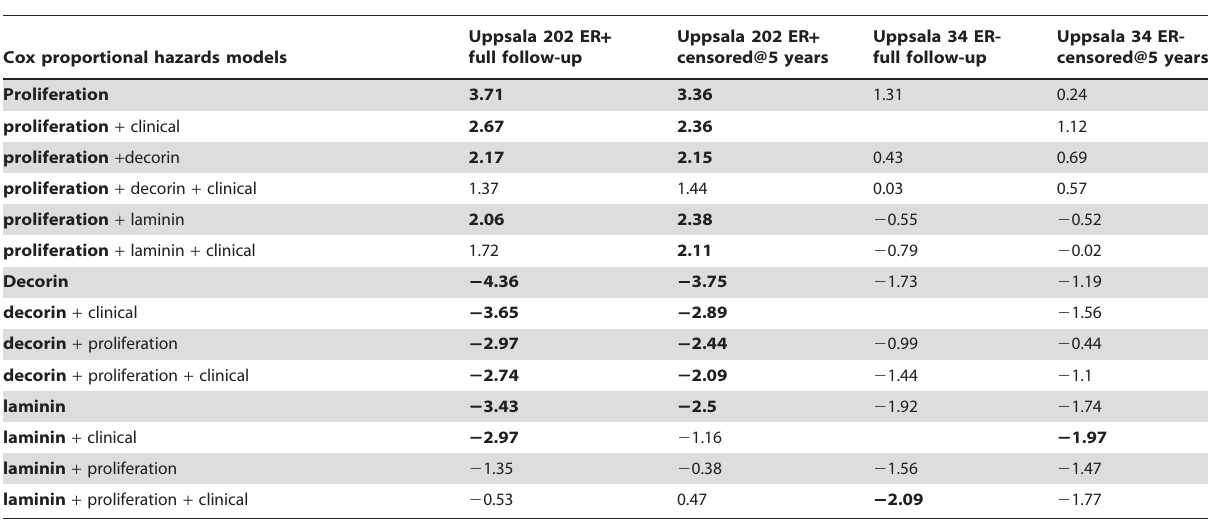
Table 2. Cox proportional hazards models for the UPPSALA cohort.